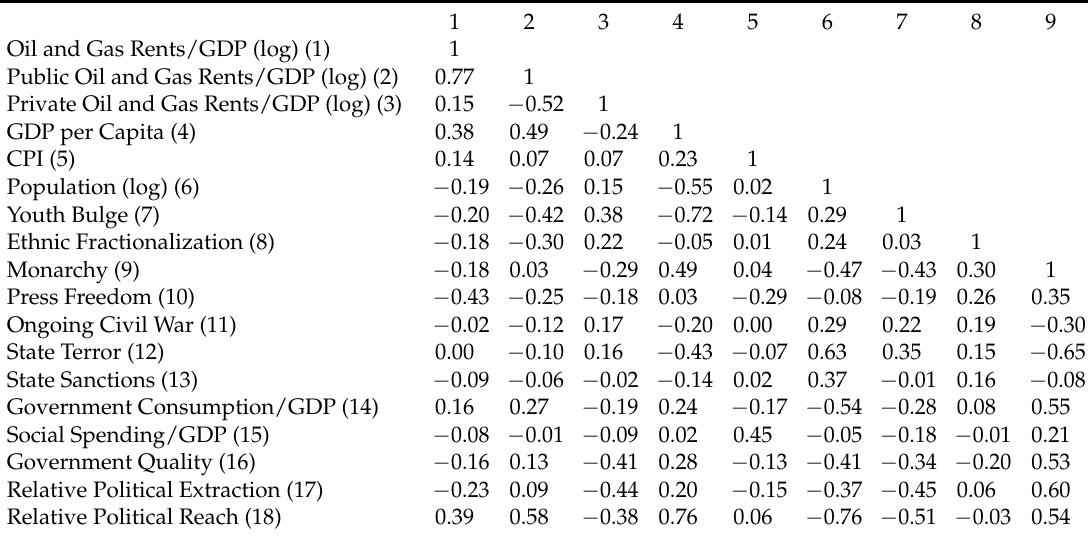
Table A1. Correlation Matrix of All Independent Variables.